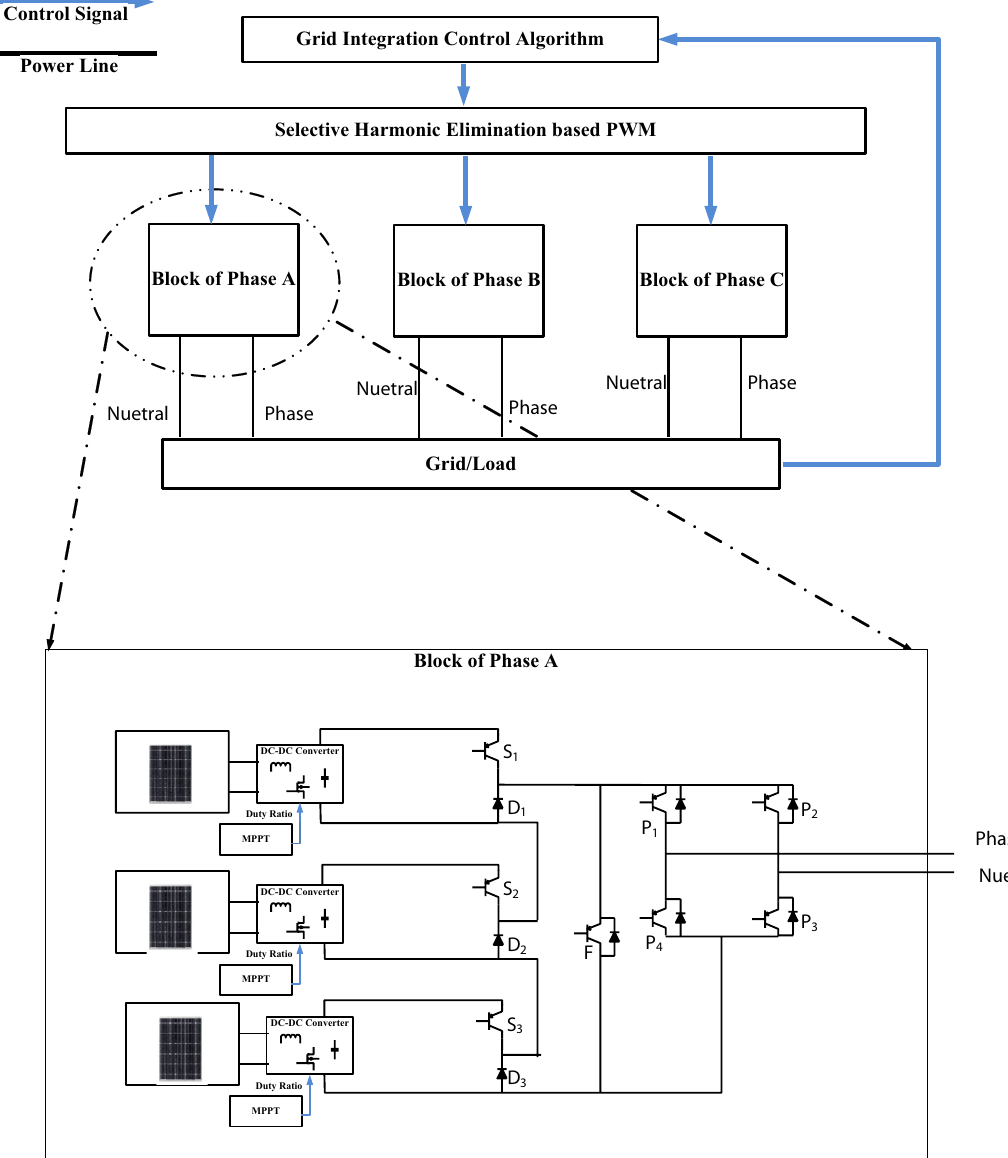
Fig. 1 Block diagram representing the